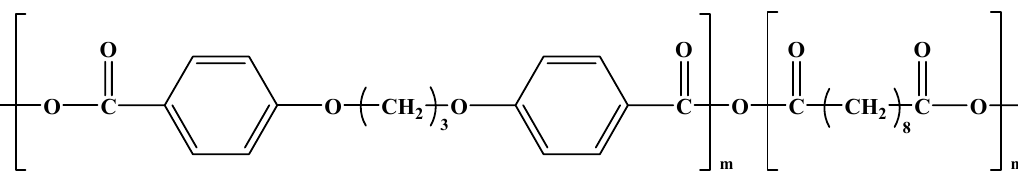
Figure 6. Chemical structure of poly[bis( p -carboxyphenoxy) propane-co-sebacic